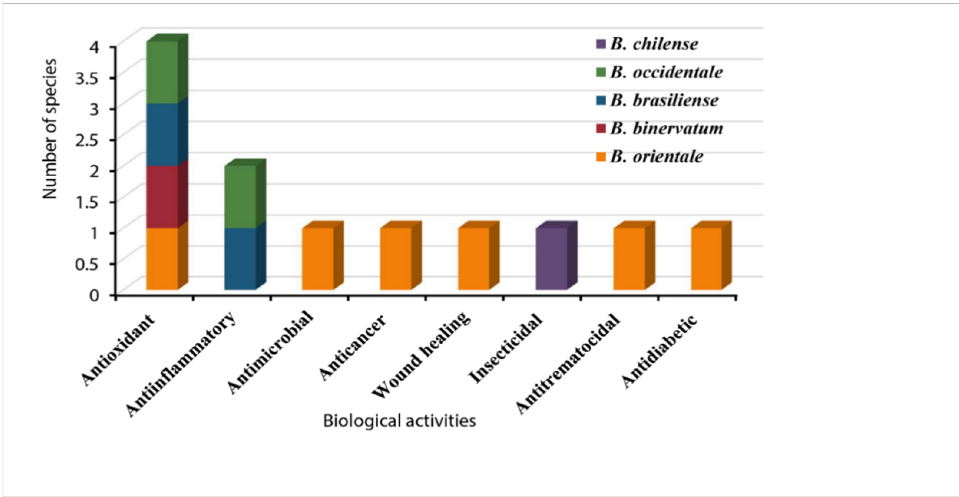
Figure 11. Types of Blechnum species with biological properties.